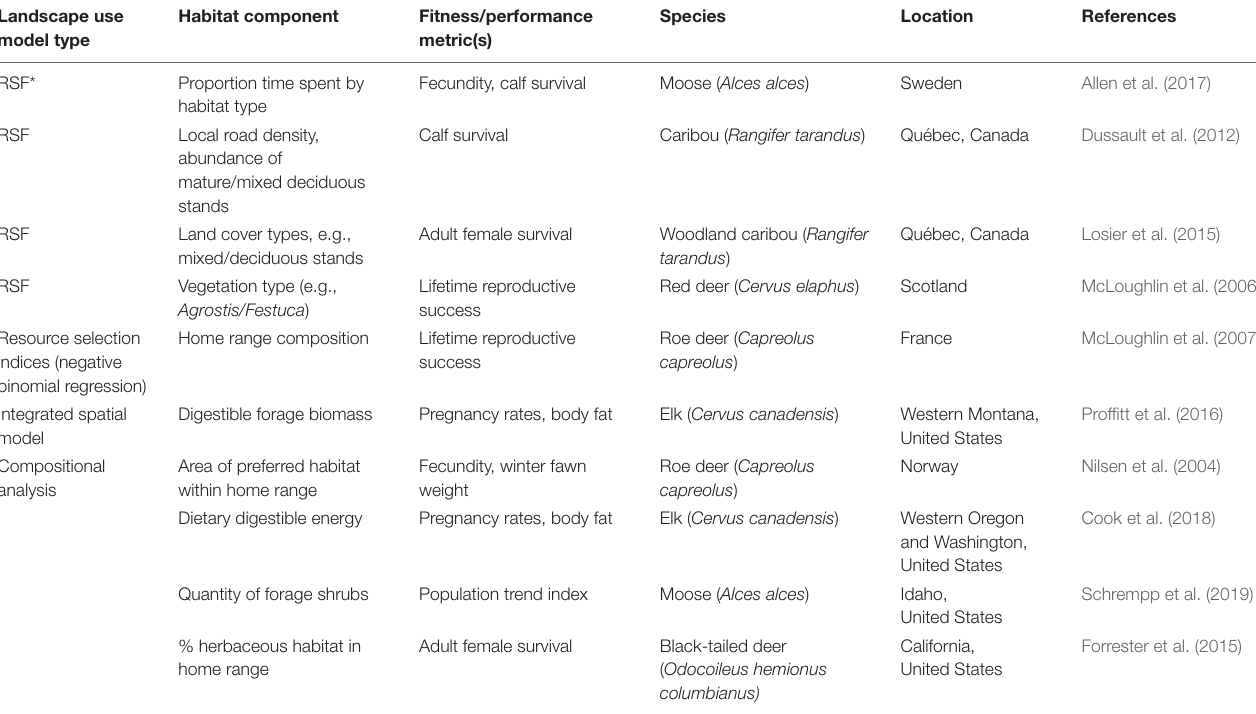
TABLE 2 | Examples of ungulate landscape-use models or habitat components that demonstrated relationships between landscape use and animal or population performance. Landscape use model